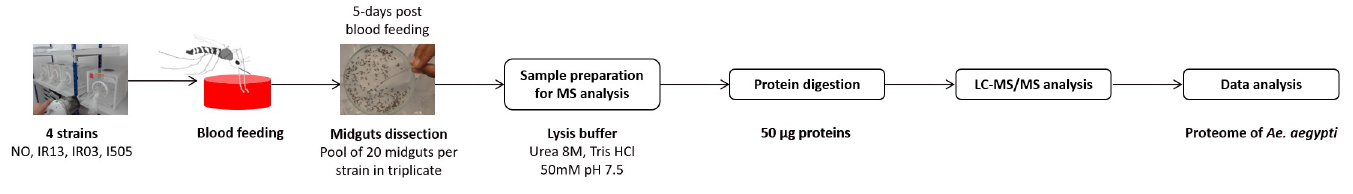
Fig 1. Mains steps of the proteomic